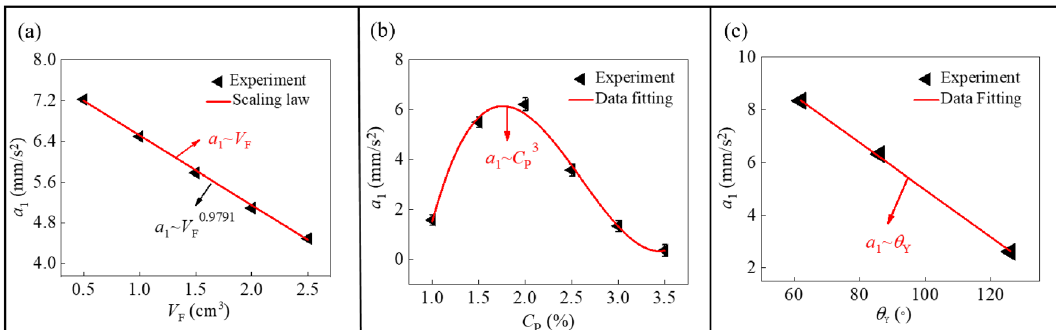
Figure 6. Dependence relationship between the maximum acceleration in the first stage a 1 and various parameters, i.e. ( a ) the volume of the foam V F , ( b ) the concentration of the magnetic particles C P , and ( c ) the Young’s contact angle θ Y